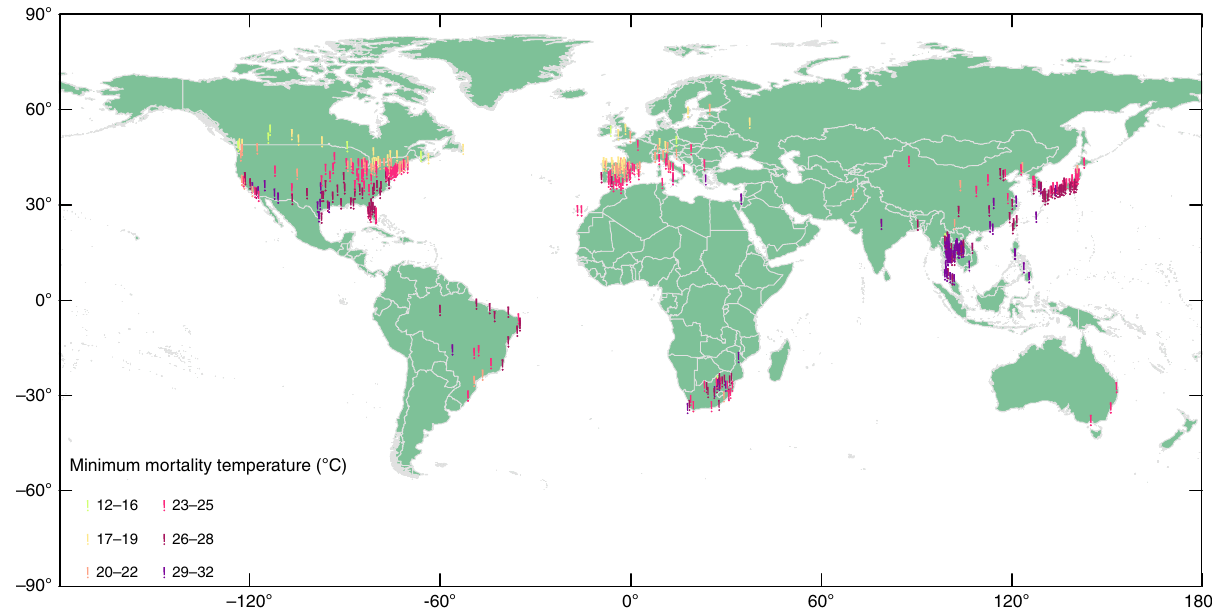
Fig. 1 Overview of minimum mortality temperature (MMT) samples. MMTs in 420 locations are shown. From low latitude to high latitude, MMT tends to decrease gradually. Among these 420 locations, the highest and lowest MMTs are 32 °C and 12 °C, respectively